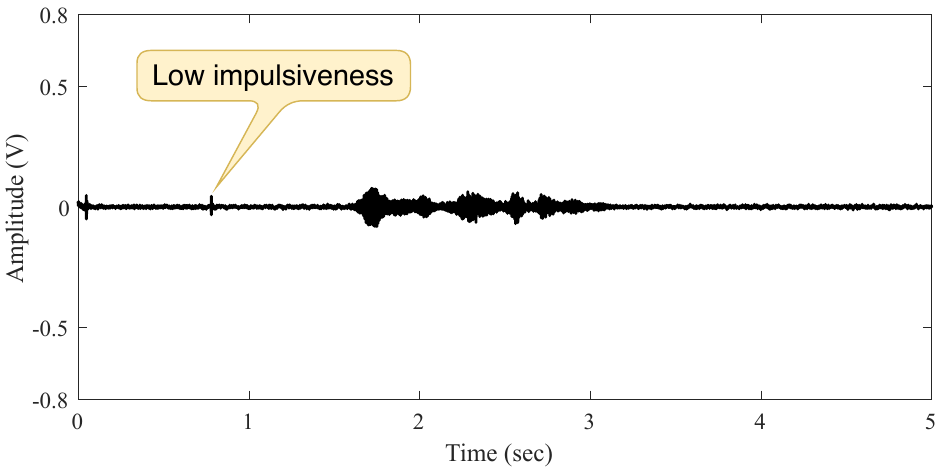
Figure 4. Signal behavior in the indoor scenario with a person moving and